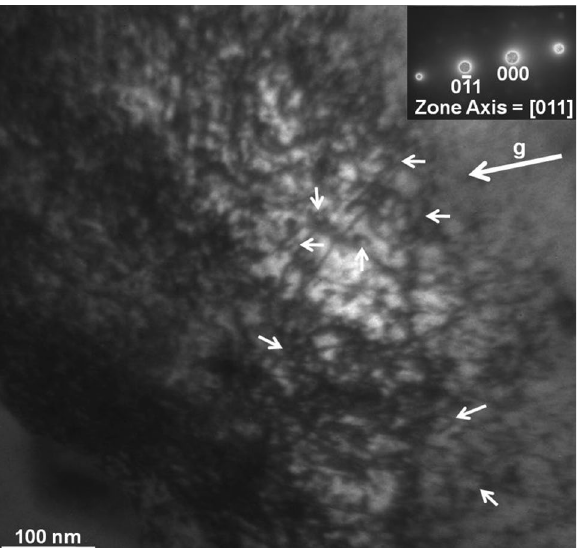
Figure 14. Bright-field TEM micrograph of the sampleirradiated to 0.2 dpa at 77 K temperature showing an insight within the damage zone. The dislocation loops are marked by small arows. The diffraction conditions used for imaging are provided as inset in form of diffraction pattern and g-vector.